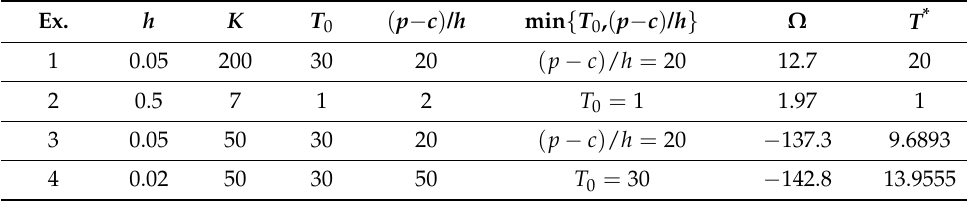
Table 2. Parameters for h , K , and T 0 as well as for derived Ω and T ∗ .